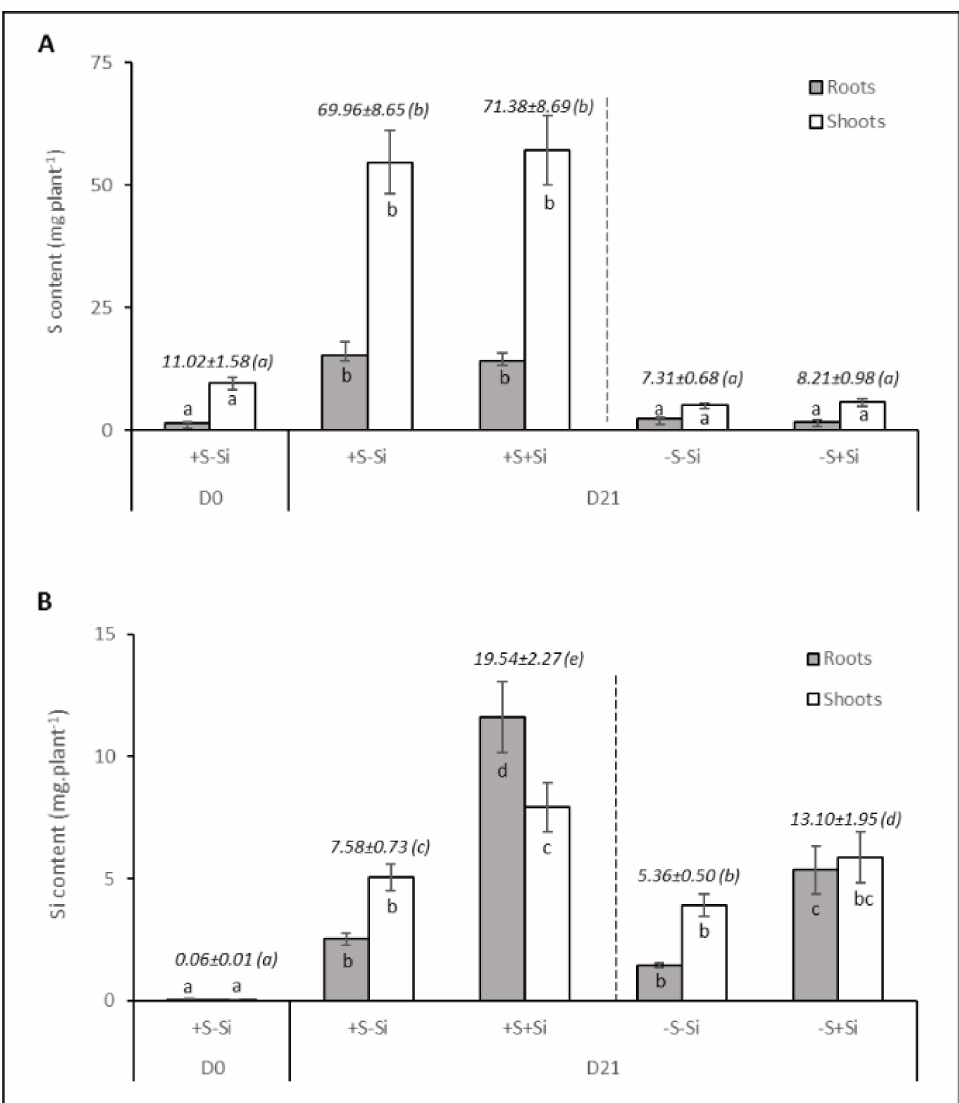
Figure 3. Roots, shoots and total contents of S ( A ) and Si ( B ) in Brassica napus L. cultivated in hydroponic conditions for 21 days (21D) with (+S; 500 µ M) or without sulfur (–S; 0 µ M) concentrations and with (+Si; 1.7 mM) or without silicon (–Si) supply. Italic values indicate the content S or Si in whole plant (mg plant − 1 ). Data are means ± SE (n = 4). Different Latin letters indicate that the S or Si content in whole plant or in each plant compartment (roots or shoots) are significantly different ( p <